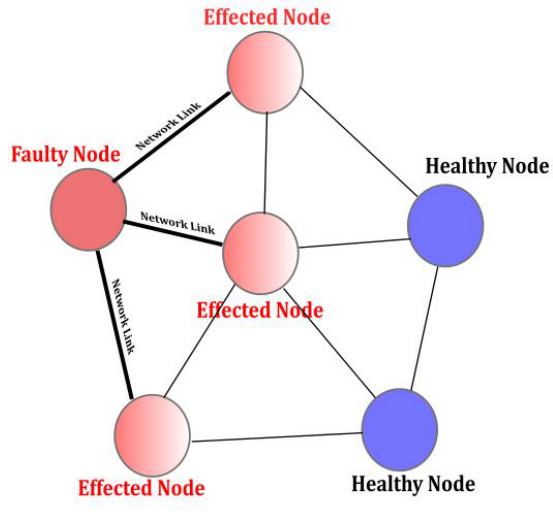
Figure 1. Control over communication network.